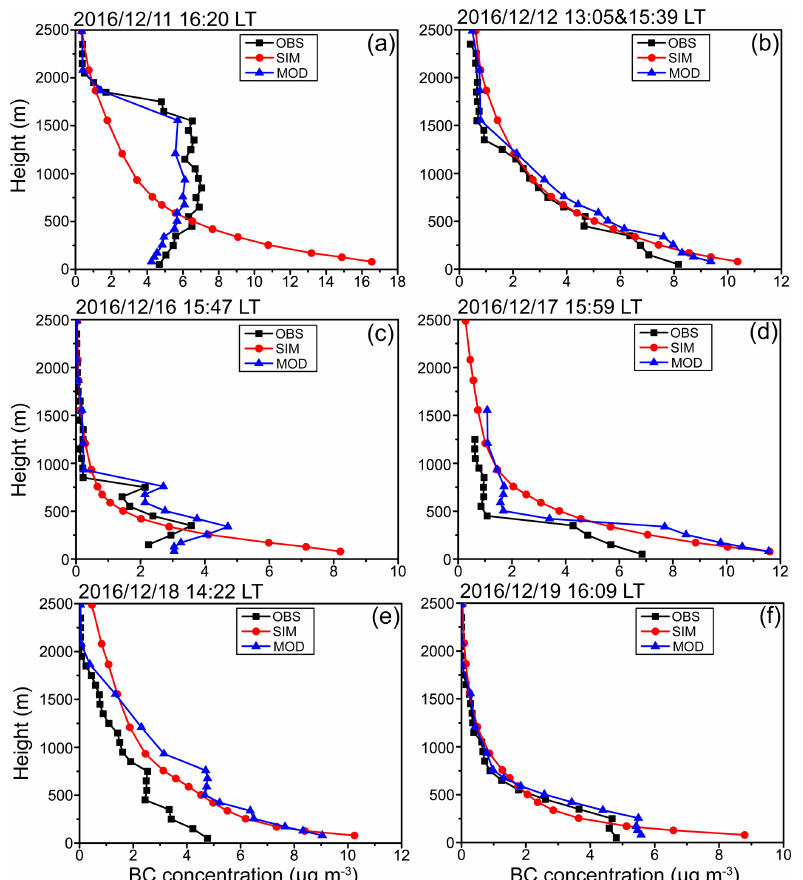
Figure 4. Observed (black line), simulated (red line), and modified (blue line) BC vertical profiles in Beijing on 11–12 and 16–19 December 2016. The time of observation is indicated on top of each panel. The model results are 2h averages around the observation time.